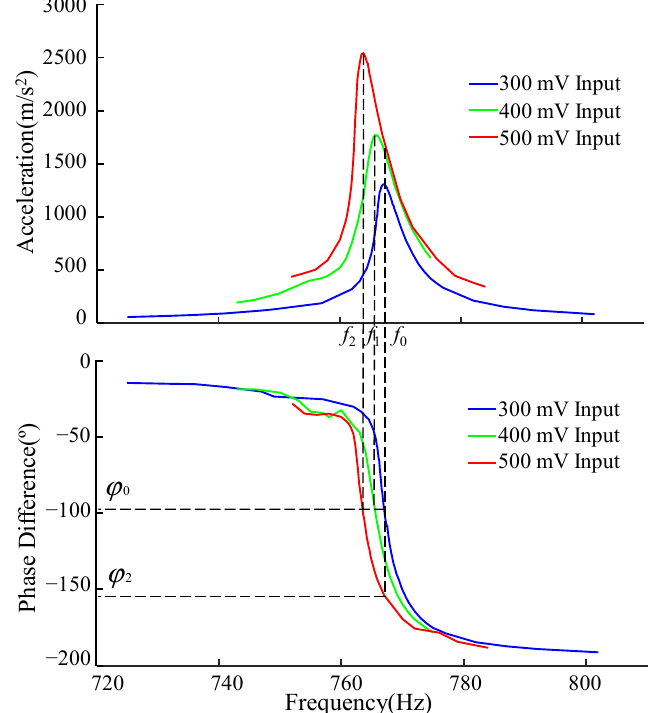
Figure 7. Amplitude–frequency and phase–frequency characteristic curves.